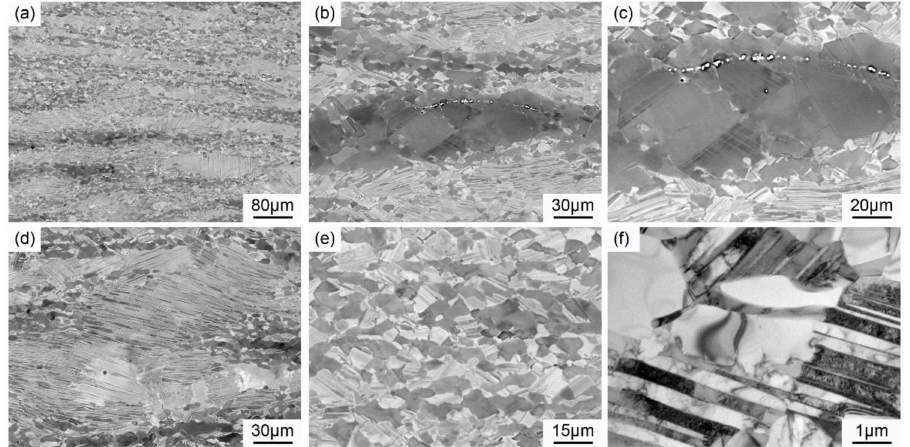
Figure 7. Multiple microstructures of the pack-rolled Ti-46Al-8Nb alloy with a reduction of 80%. ( a ) Deformed-ribbons structure, ( b ) local recrystallization, ( c ) lumpy γ phase at the grain boundary region, ( d ) retained lamellar colony, ( e ) fine recrystallized structure, and ( f ) TEM images for lamellar